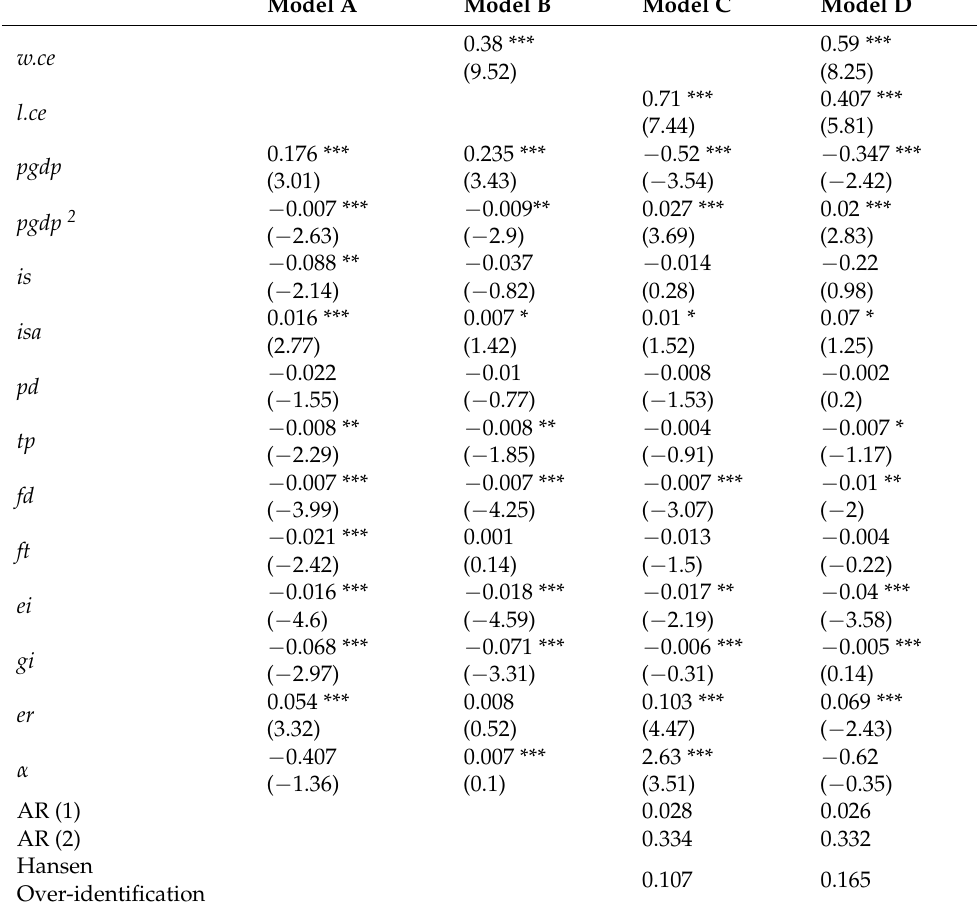
Table 3. The estimation results of spatial econometric